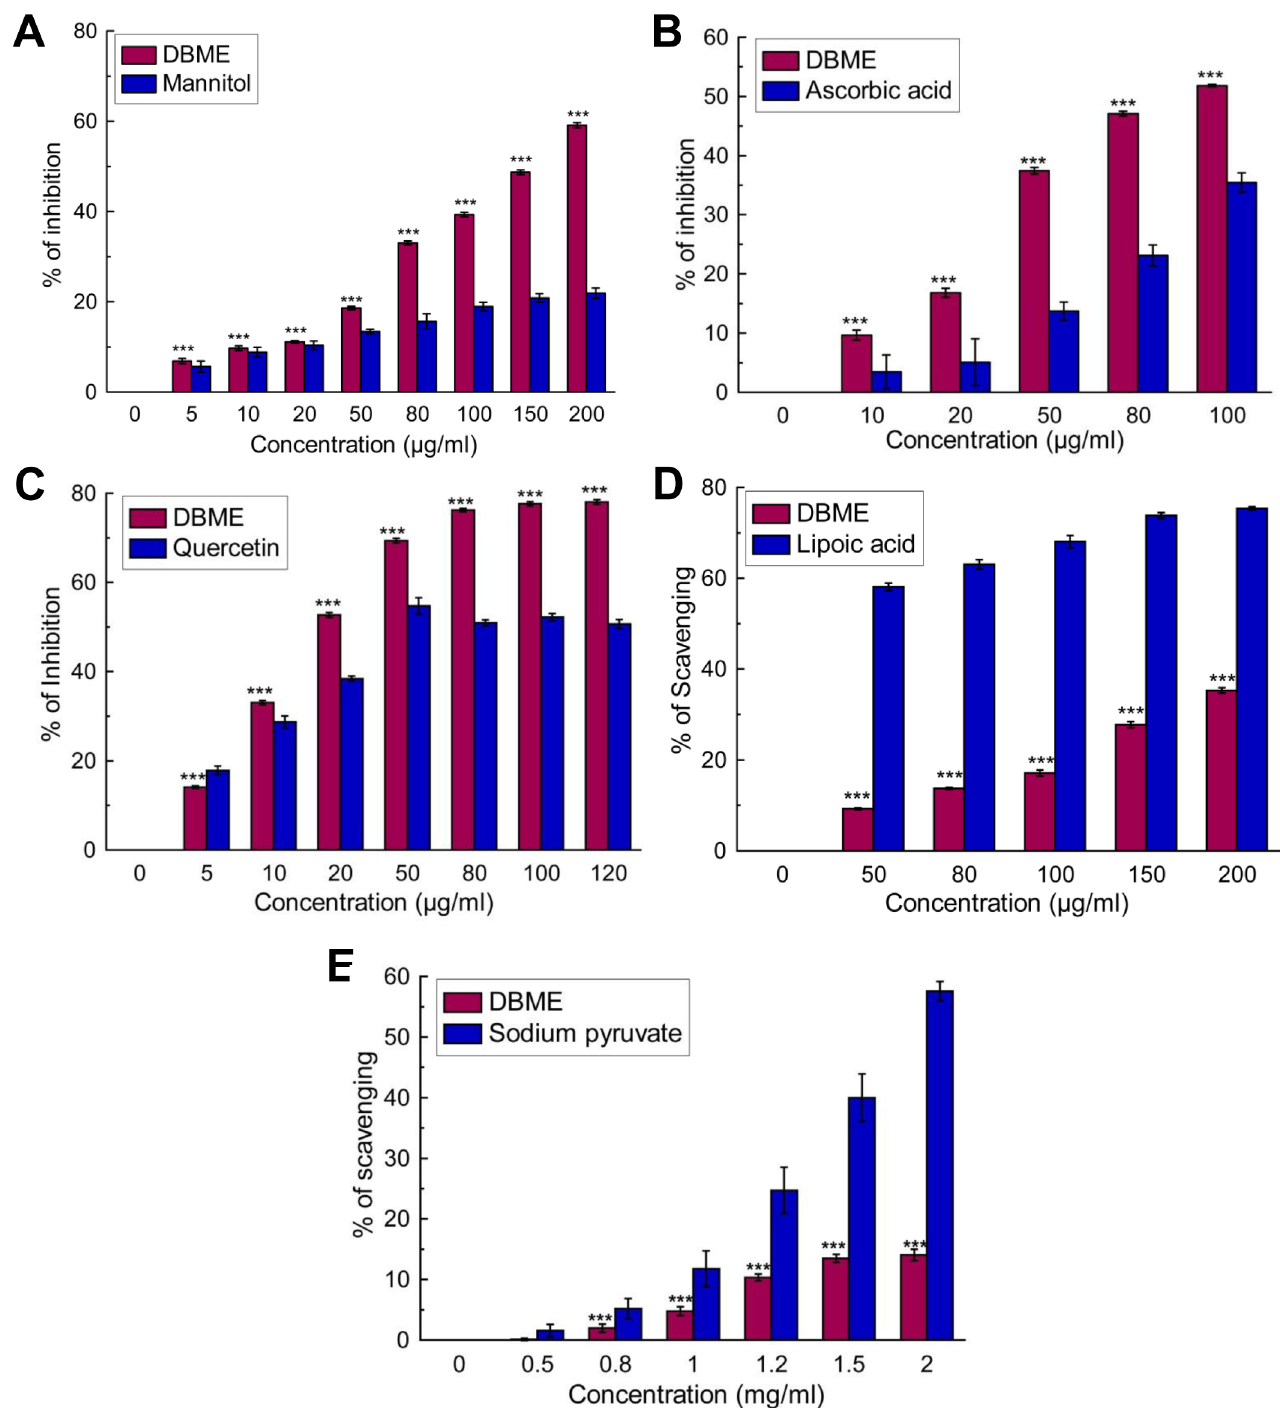
Fig 2. Reactive oxygen species scavenging activity of DBME and the reference compounds. (A) Hydroxyl radical inhibition, (B) hypochlorous radical scavenging, (C) superoxide radical inhibition, (D) singlet oxygen radical scavenging, (E) hydrogen peroxide scavenging. The results are mean ± S.D. of six parallel measurements. *** p < 0.001 vs. 0 μ